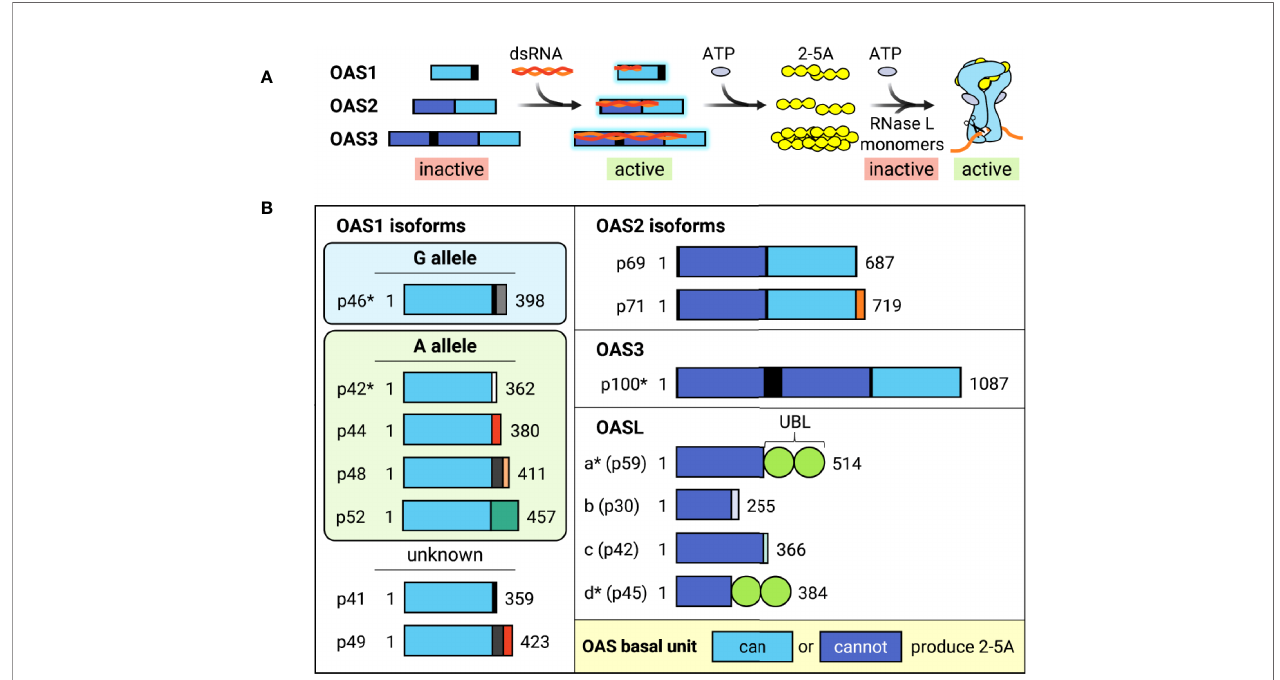
FIGURE 3 | Activation and dsRNA binding of OAS isoforms. (A) Diagram of how OAS is activated by viral dsRNA and synthesizes 2-5A to activate RNase L. Longer OAS isoforms are activated by longer dsRNA. Though all are able to synthesize 2-5A, OAS3 2-5A synthesis is necessary and suf fi cient for RNase L activation. RNase L exists as inactive free monomers, but dimerizes and activates upon binding to 2-5A and ATP, thereby cleaving RNA. Interestingly, IFN and some ISG transcripts are resistant to RNase L cleavage, resulting in preservation of antiviral signaling. (B) Schematic of known human OAS isoforms encoded by OAS genes OAS1, OAS2, OAS3, and OASL. Isoforms marked with * have demonstrated direct antiviral activity. Length of boxes approximates gene length, with different colored C-terminal boxes representing different coding sequences. Light blue OAS basal units are able to synthesize 2-5A, while dark blue OAS basal units are catalytically inactive. Most OAS1 isoforms are expressed by either G or A alleles, which differ by the inclusion of a G or A nucleotide at a splice acceptor site. However, OAS1 p41 and p49 have not been attributed to either G or A and are therefore labelled as “ unknown. ” UBL, Ubiquitin-like